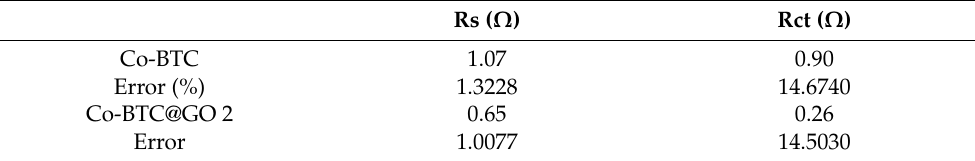
Table 2. Equivalent circuit parameters obtained from EIS plots of Co-BTC and Co-BTC@GO 2. Rs ( Ω ) Rct ( Ω ) Co-BTC 1.07 0.90 Error (%) 1.3228 14.6740 Co-BTC@GO 2 0.65 0.26 Error 1.0077 14.5030